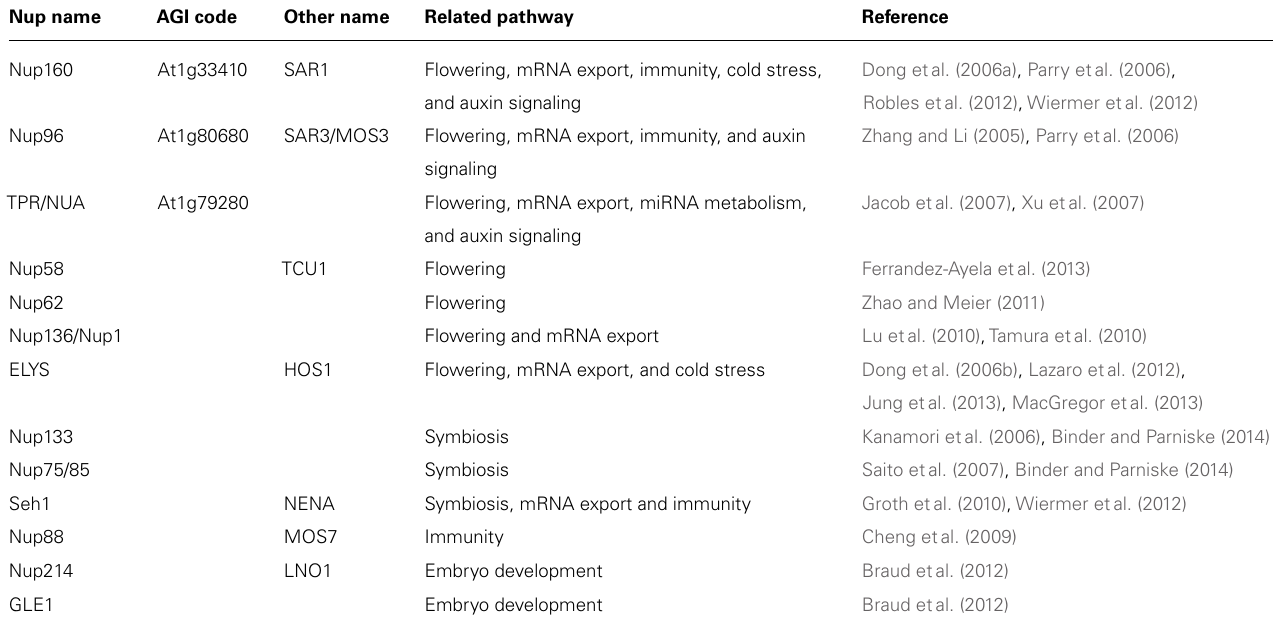
Table 1 | Identified plant nucleoporin